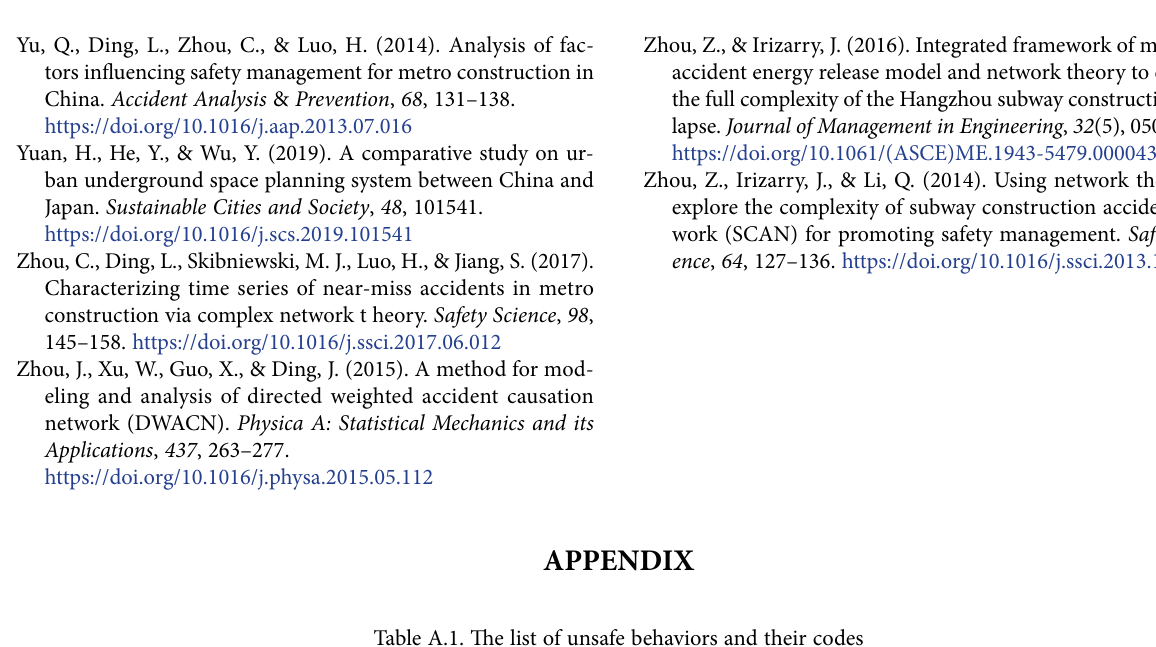
Table A.1. The list of unsafe behaviors and their